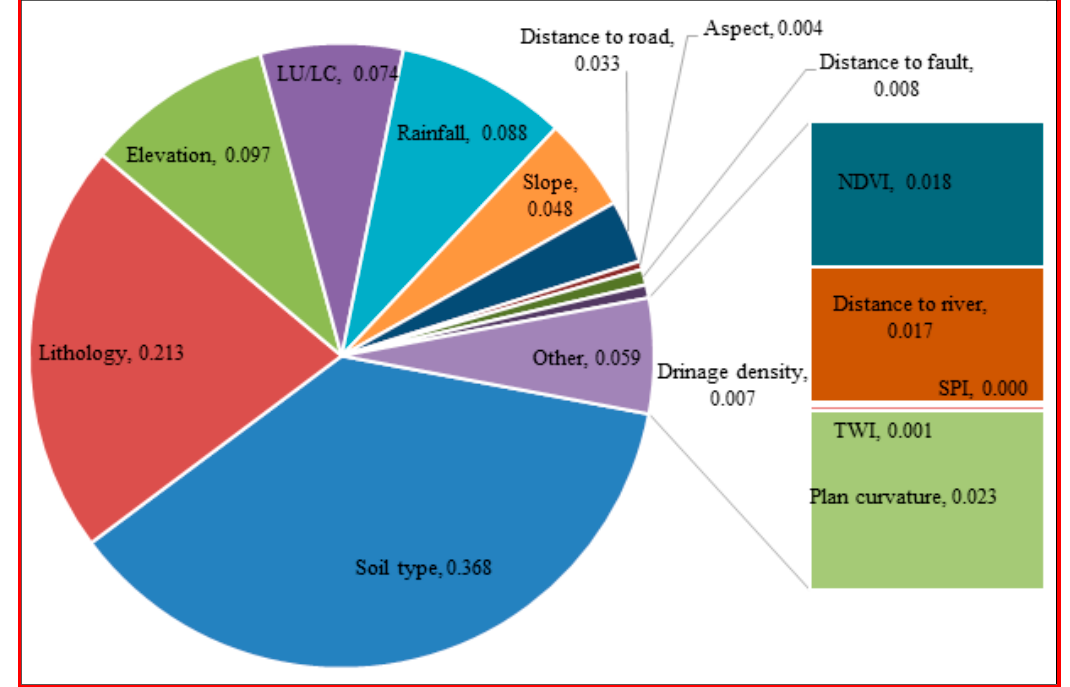
Figure 7. Weight of the criteria (gully erosion conditioning factors) using the analytic hierarchy process (AHP) model.